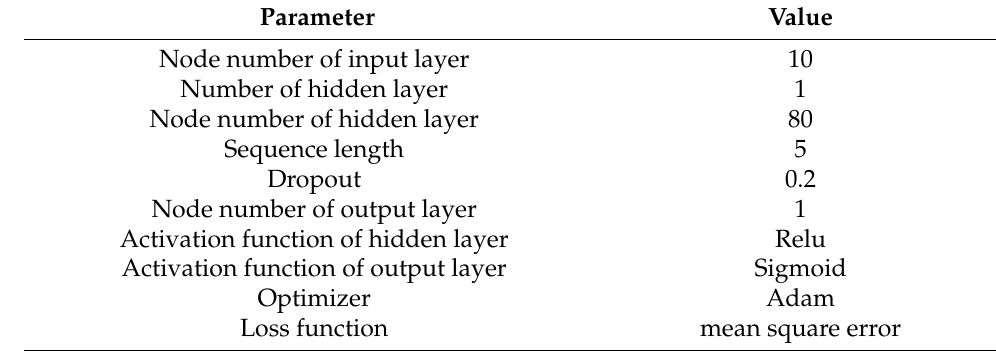
Table 5. LSTM model